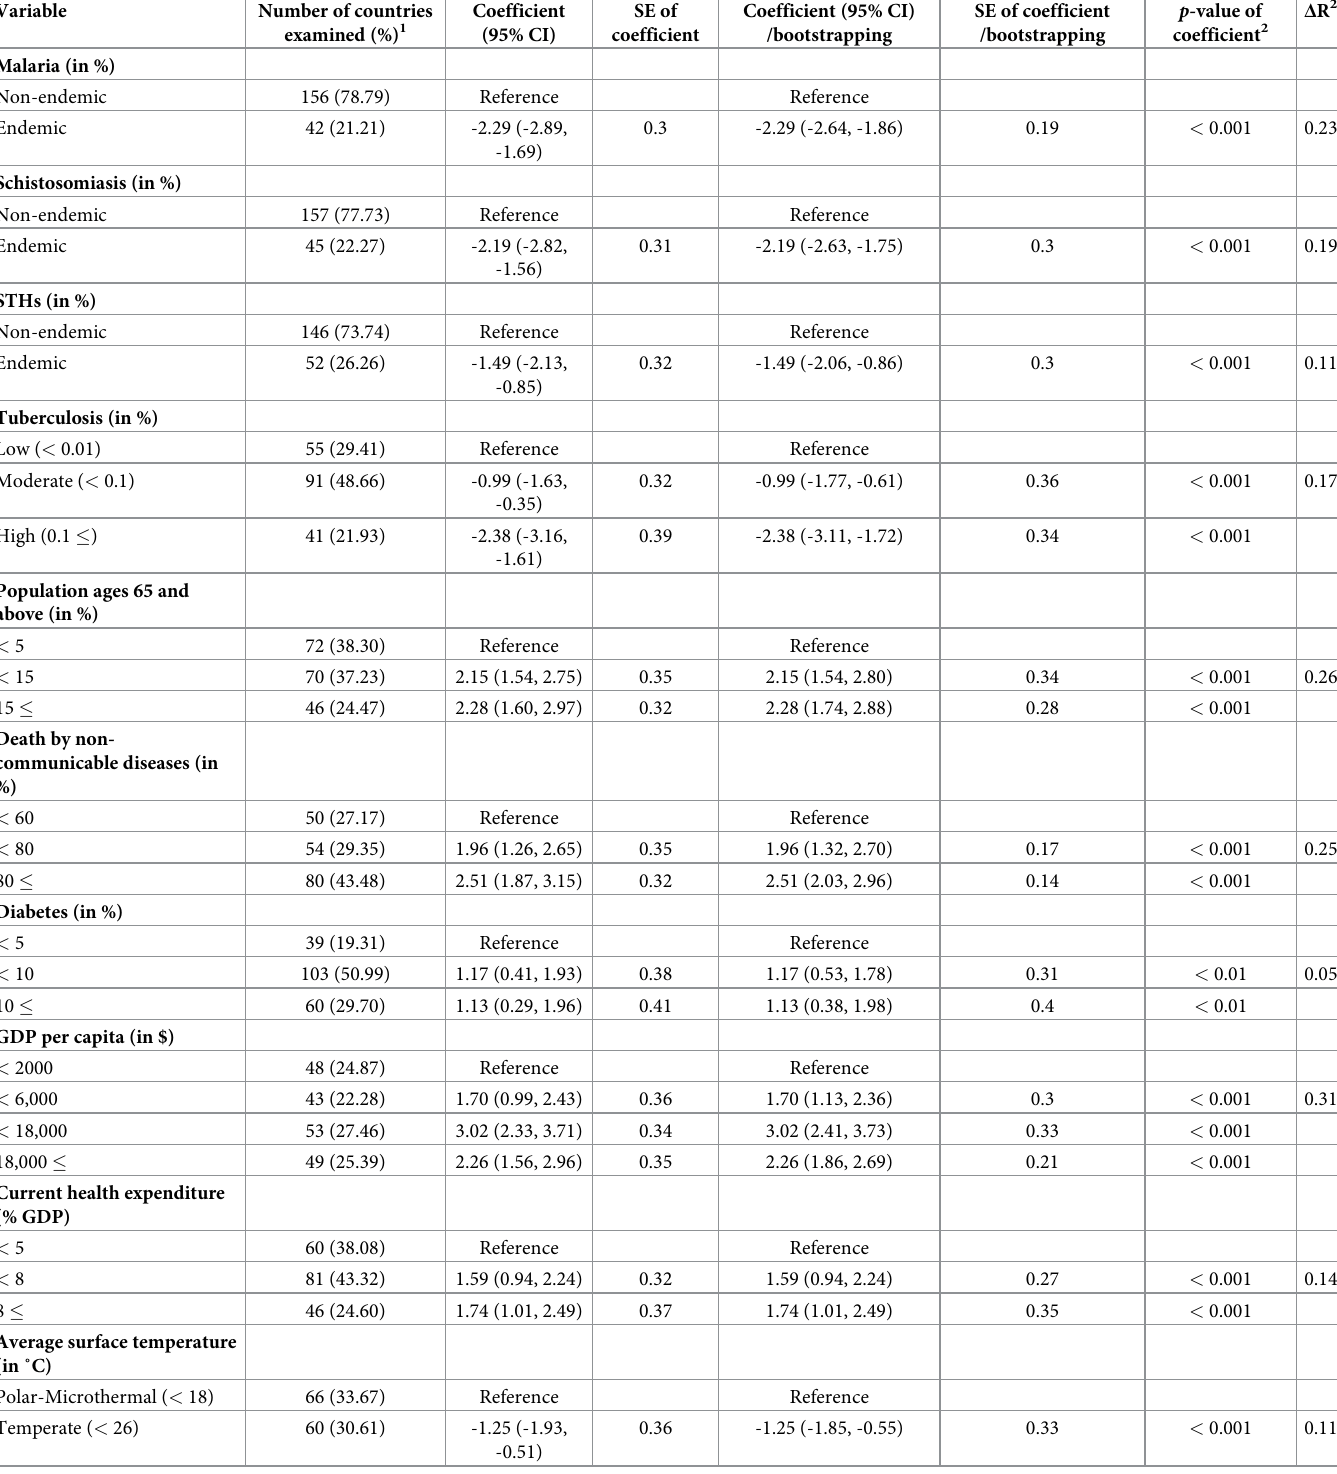
Table 3. Univariable analyses of predictive variables and root-transformed COVID-19 incidence